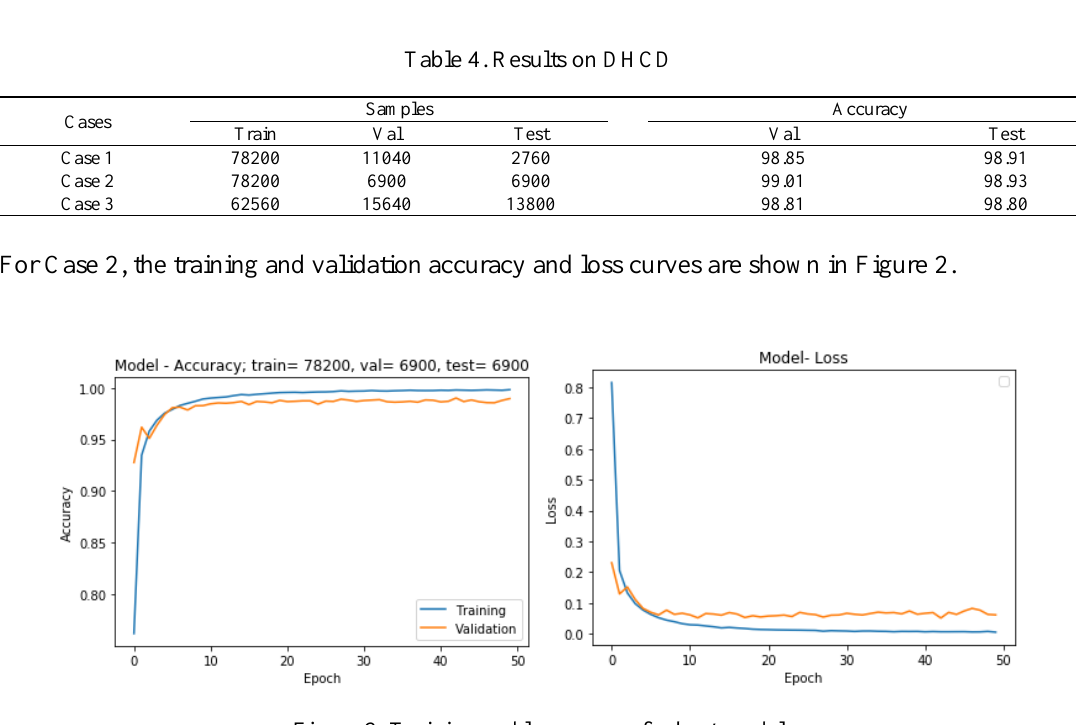
Figure 2. Training and loss curves for best